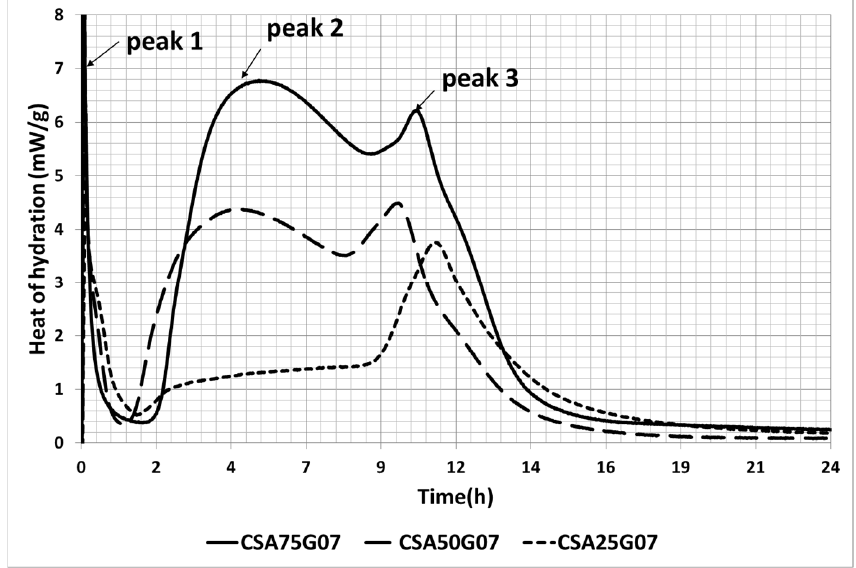
Figure 3. Heat of hydration versus time of the three CSA cement pastes with similar SO 3 /Al 2 O 3 ratio (0.7).